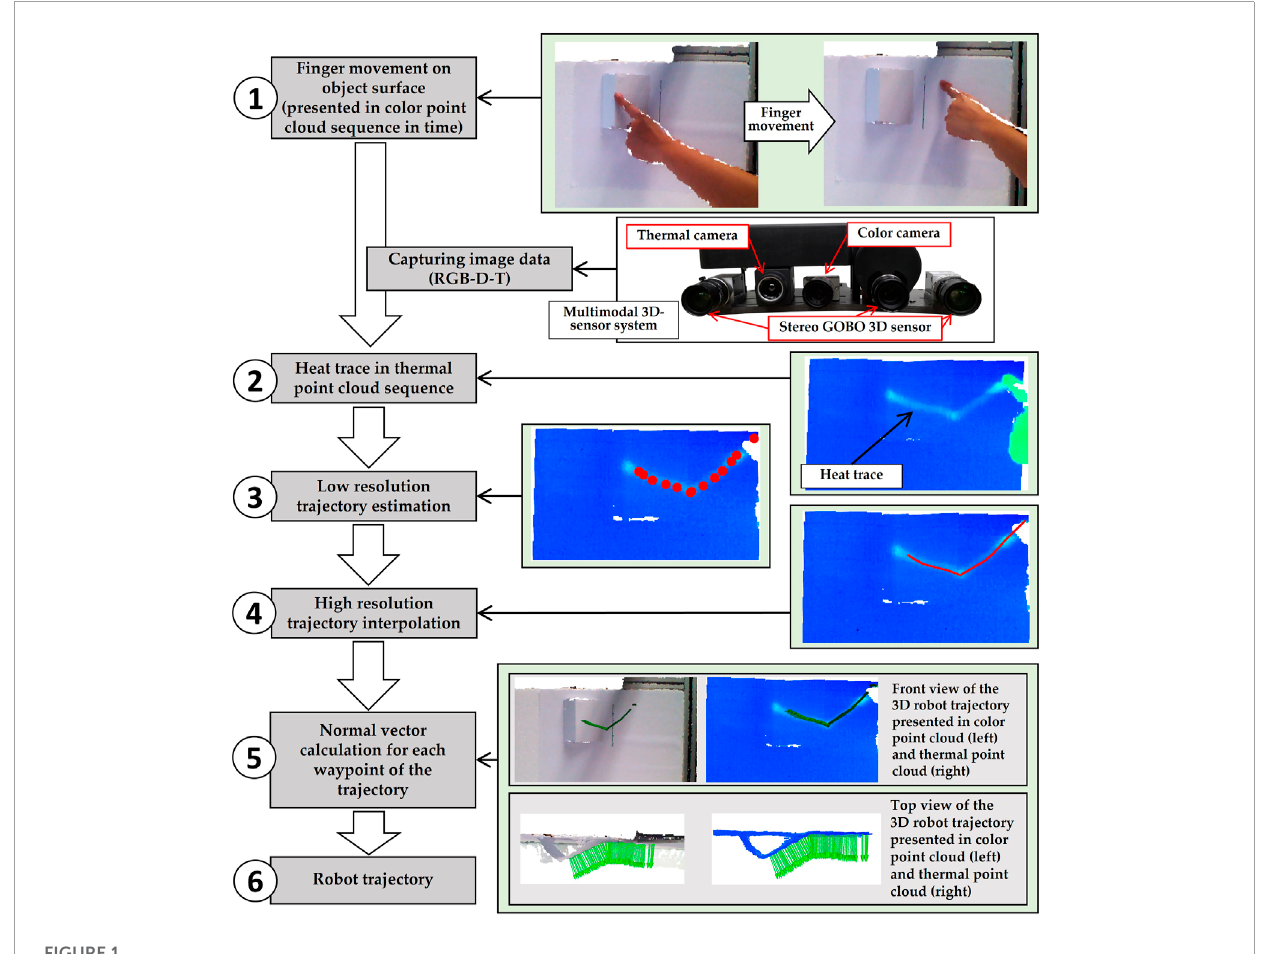
FIGURE 1 Basic concept of our approach.